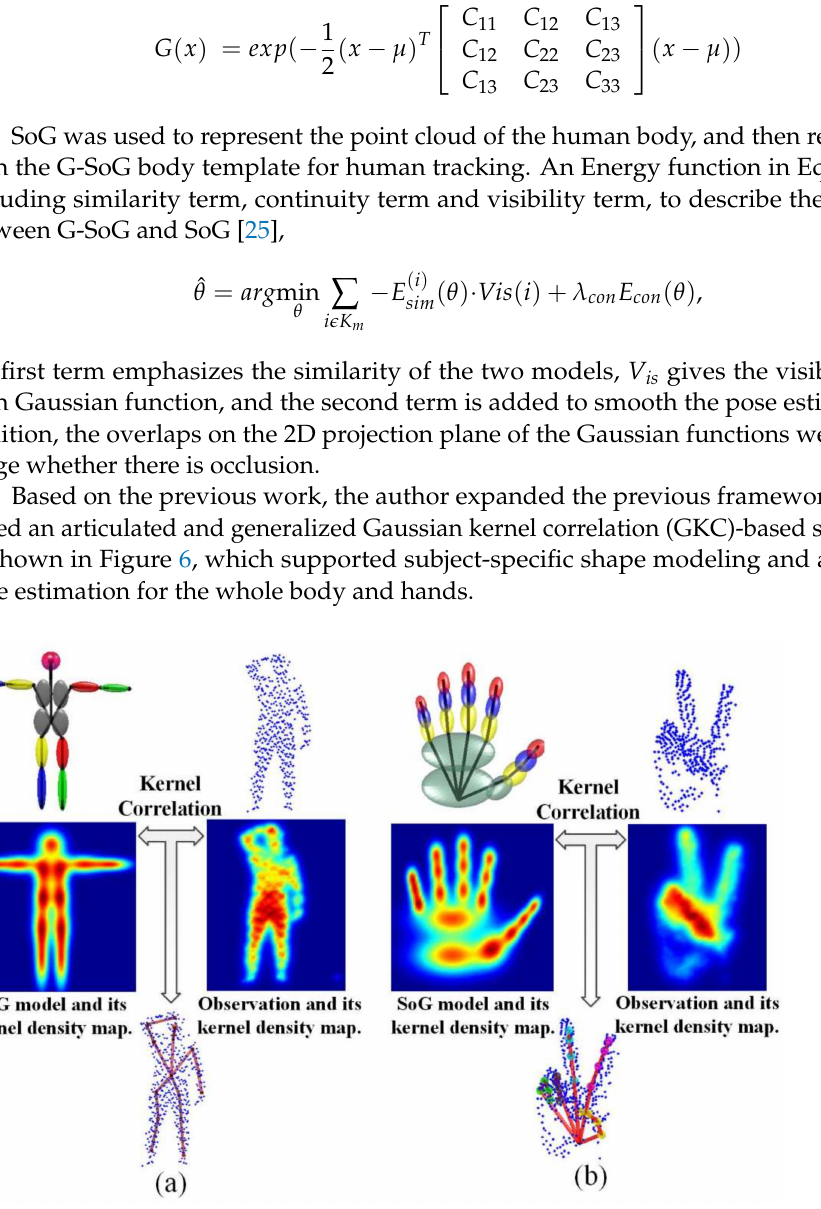
Figure 6. A conceptual scheme of mathematical model-based human joint estimation. Articulated pose estimation for the full body ( a ) and hand ( b ). The 1st row shows the Sums of spatial Gaussians (SoG) -based template models and an observed point cloud. Their corresponding Gaussian kernel density maps are depicted in the 2nd row, followed by the pose estimation results in the 3rd row. Figure from